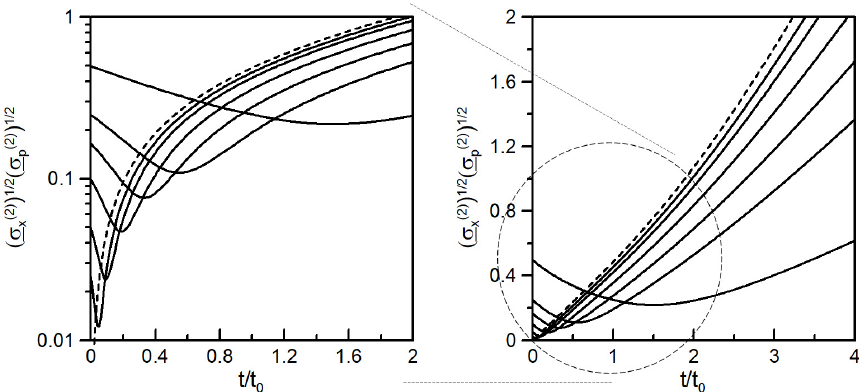
( 2 ) ( τ )) 1/2 ( σ ( 2 ) ( τ )) 1/2 for the gas case ( α = 0.1) are shown x p A